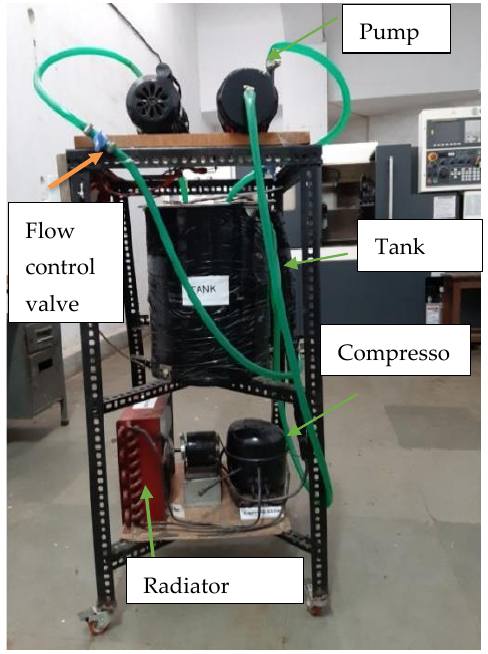
Figure 1. Refrigeration system for coolant cooling.